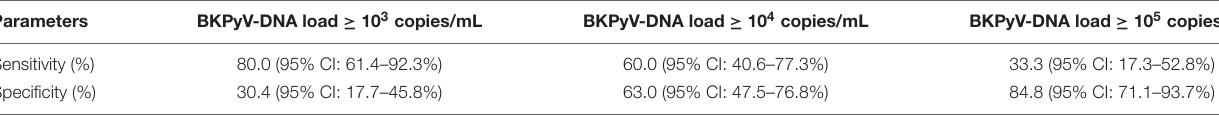
TABLE 3 | Plasma BKPyV-DNA load for predicting BKPyV infection in proximal tubular epithelium.